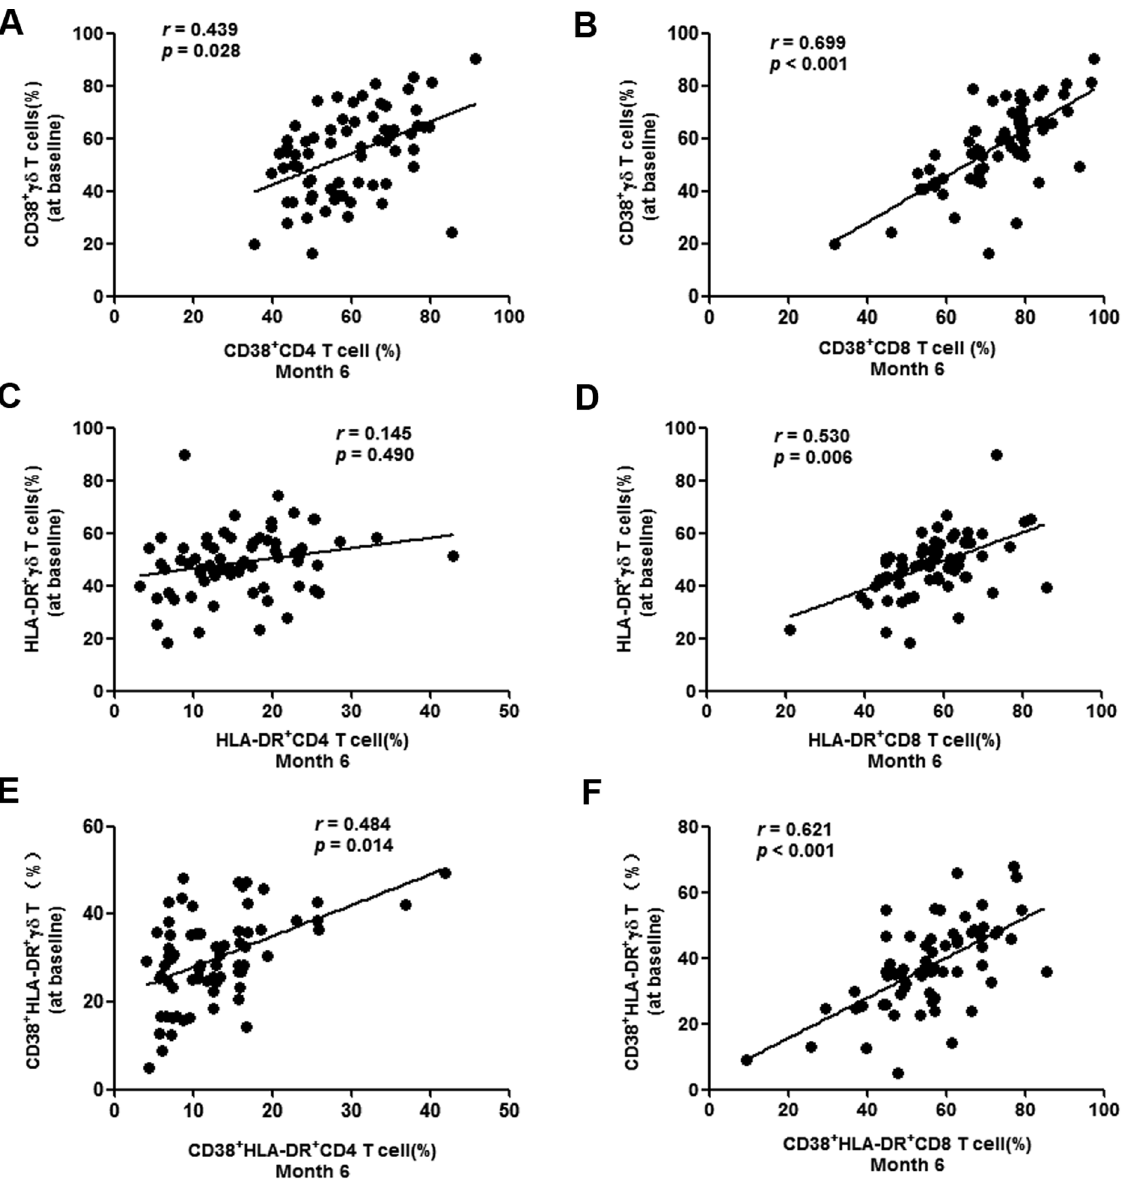
Figure 5. Correlation between early cd T cell activation and CD4/CD8 T cell activation set-point. Correlation analysis of the proportion of CD38 + /CD4 + T cells ( A ) or CD38 + /CD8 + T cells ( B ) at month 6 after baseline and CD38 + cd T cells frequency at baseline was performed by Spearman’s rank correlation, where coefficients ‘r’ and corresponding P -values are indicated on each panel. Similar correlation analysis of the proportion of HLA-DR + ( C, D ) and CD38 + /HLA-DR + cells ( E, F ) and CD4 + or CD8 + T cells at month 6 and cd T cells at baseline was performed.